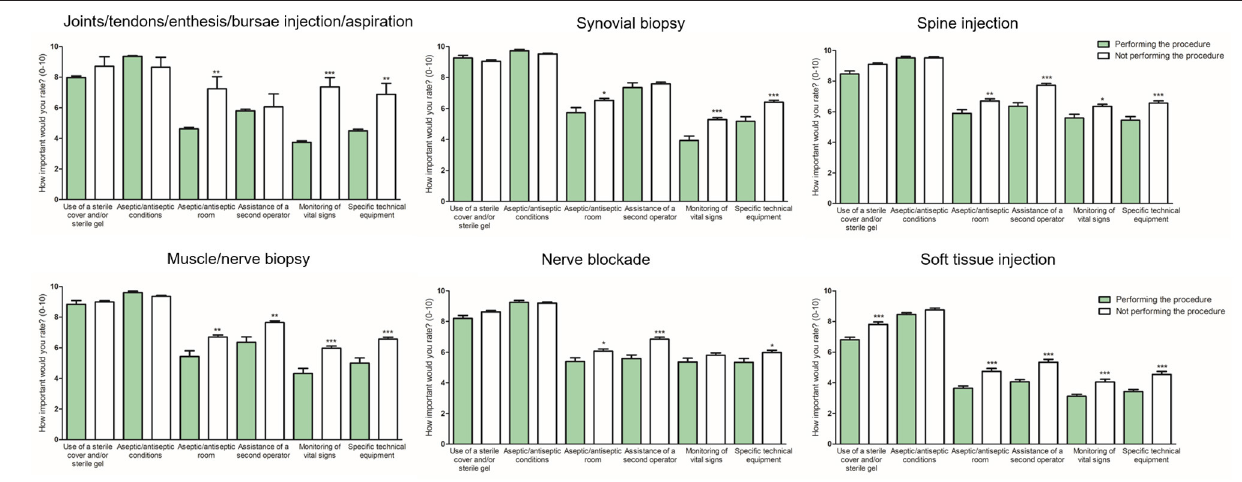
FIGURE 3 | Importance of specific preparations and settings according to respondents performing/not performing interventional procedures. Bars indicate mean and standard error of the mean. *** p < 0.001, ** p < 0.01, and * p <